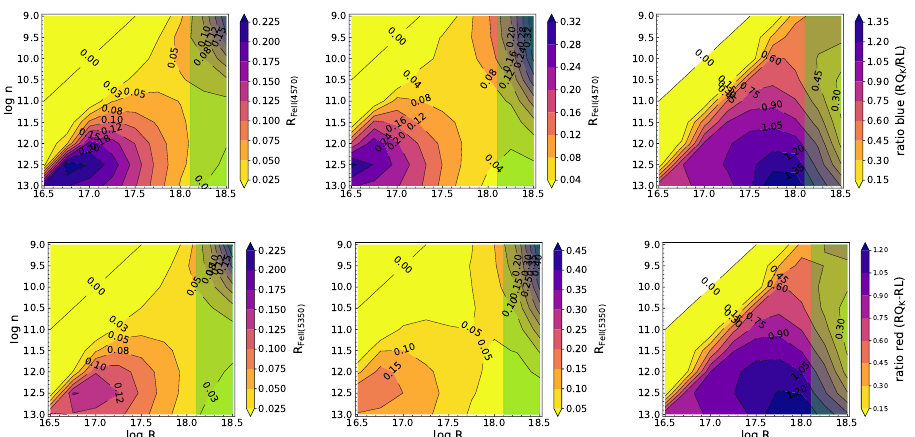
Figure A2. Results of CLOUDY simulations, same as in Figure 12 but for the RQ SED of Korista et al. [89].